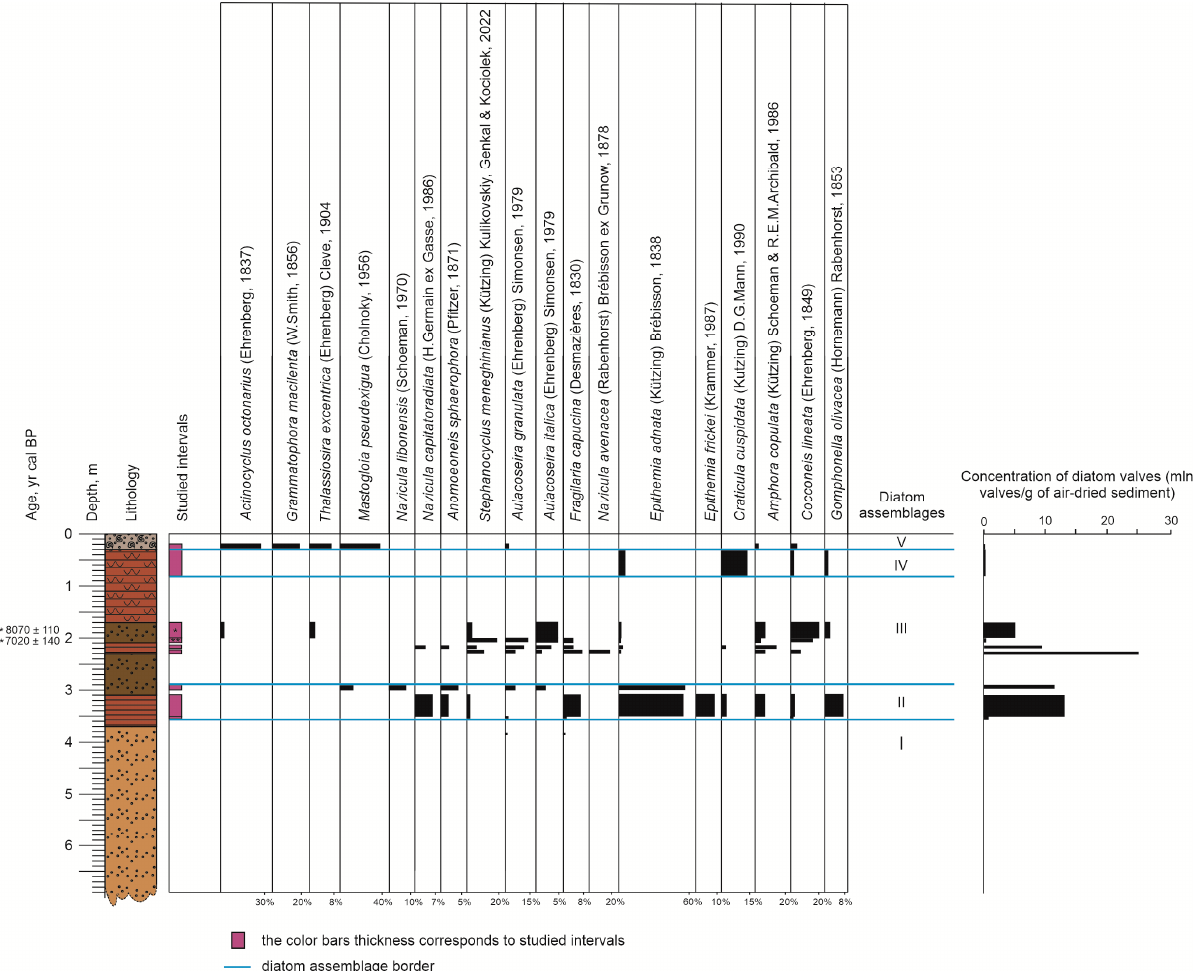
Figure 5. Diatoms of the studied Rybachya core. (1) Actinocyclus octonarius ; (2) Thalassiosira eccentrica (Ehrenberg) Cleve, 1904; (3) Aulacoseira italica (Ehrenberg) Simonsen, 1979; (4) Stephanocyclus meneghinianus ; (5) Cocconeis lineata ; (6) Grammatophora macilenta ; (7) Navicula avenacea ; (8) Mastogloia pseudexigua; (9) Lyrella lyra; (10) Anomoeoneis sphaerophora (Pfitzer, 1871); (11) Epithemia adnata